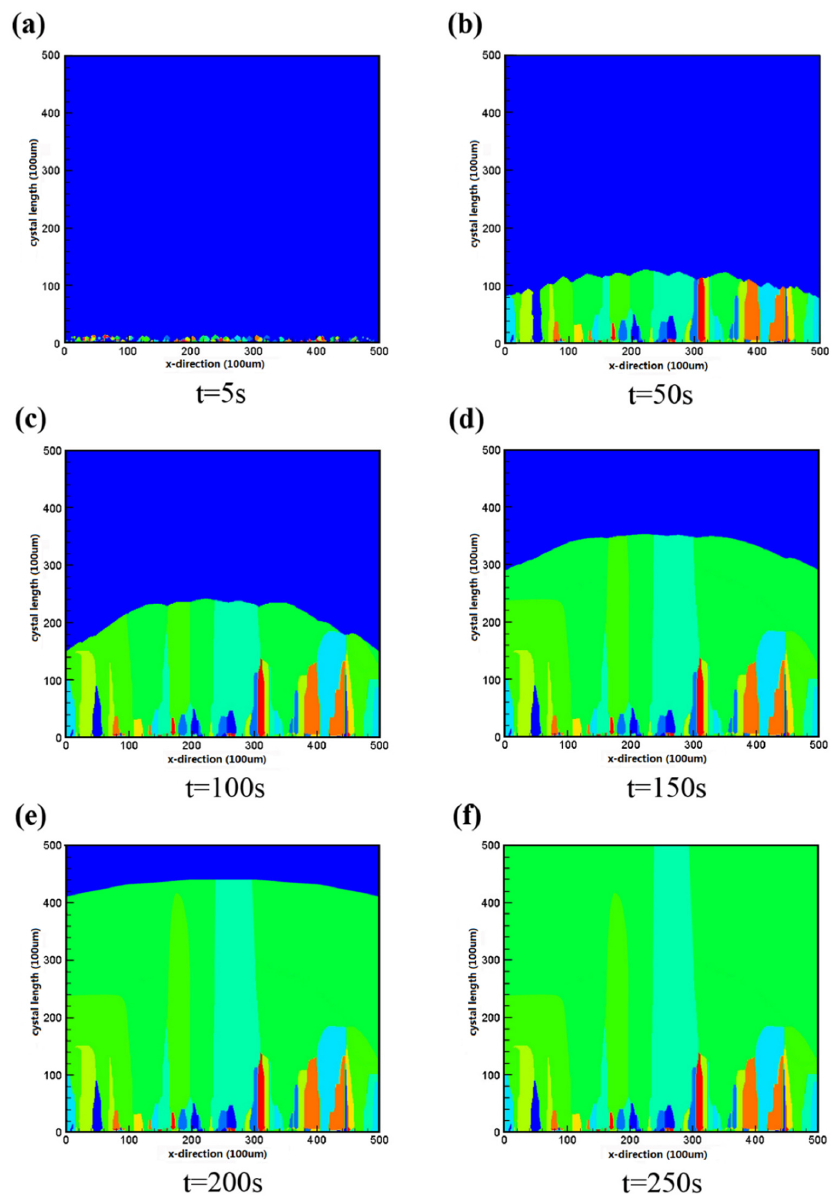
Figure 7. The crystal growth at different times: ( a ) t = 5 s; ( b ) t = 50 s; ( c ) t = 100 s; ( d ) t = 150 s; ( e ) t = 200 s; and ( f ) t = 250 s.